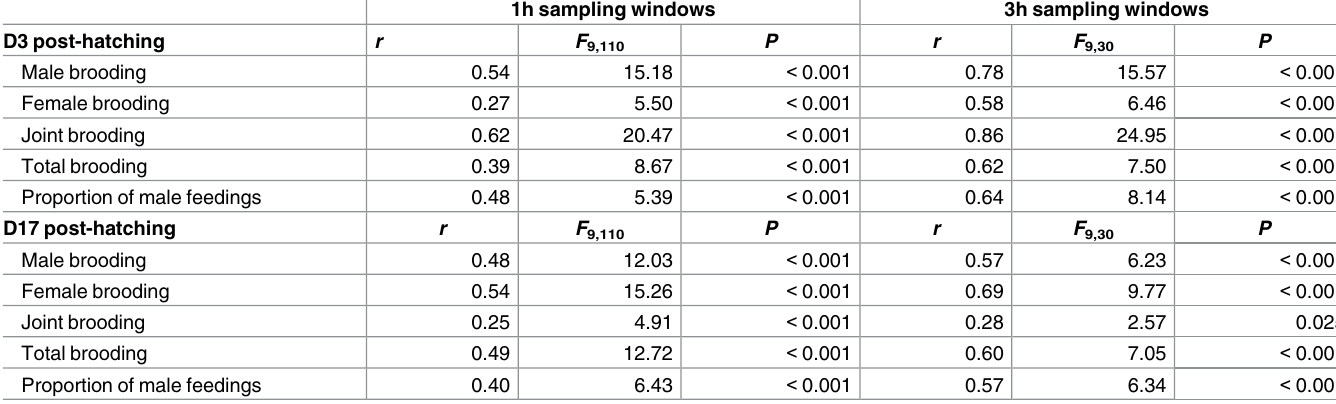
Table 3. Consistency of parental effort over the course of the day using 1h and 3h sampling windows on day 3 and day 17 post-hatching, separately.